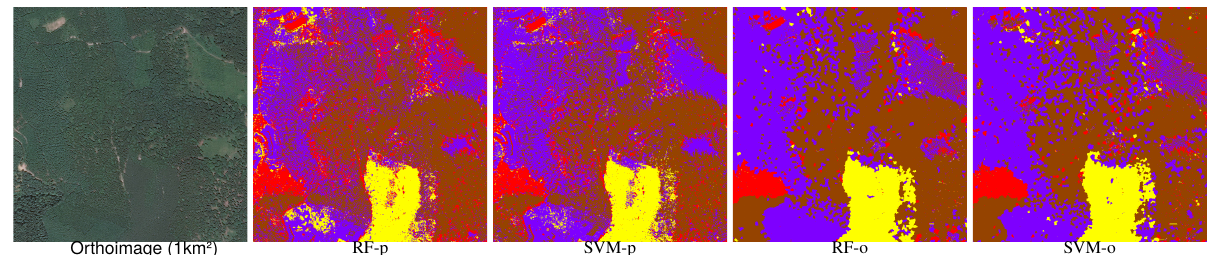
Figure 5. Classification results; comparison of the classifiers and of the pixel and object based approach. Species colour codes : beech, chestnut, robinia, oak, Scots pine, Douglas, spruce, woody heathland, herbaceous formation.